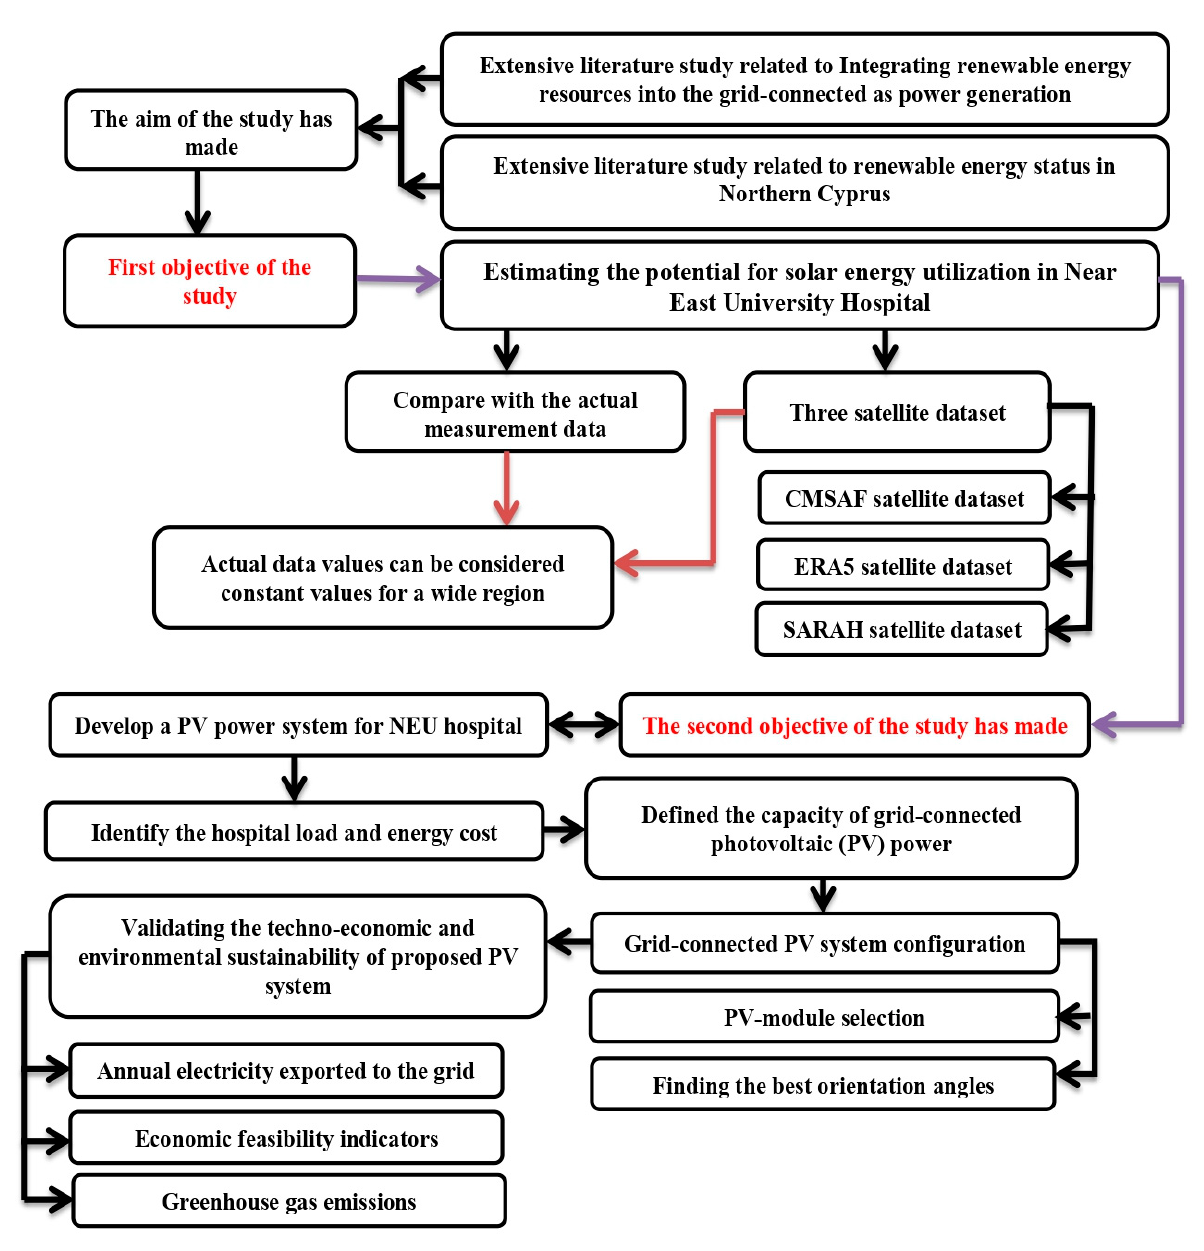
Figure 1. Schematic diagram of the developed methodology.